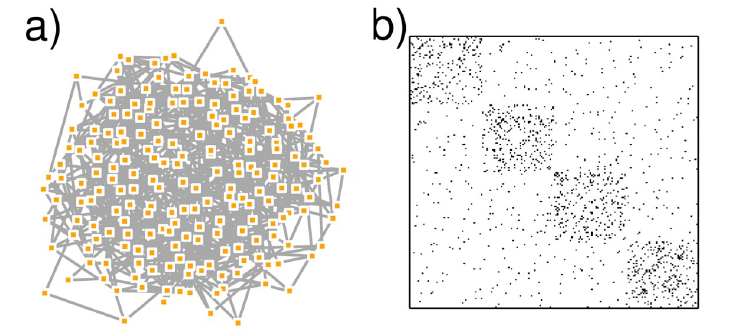
Fig 2. Synthetic network with 200 nodes and 700 edges generated with an SBM (see Tip 6) with 4 clusters of intraconnectivity and interconnectivity of 0.1 and 0.015, respectively. (a) Network visualization with Kamada and Kawai layout does not highlight any modular structure, whereas it exists. (b) Representation of the adjacency matrix with row and columns ordering consistent with the 4 clusters. Performed with the R package igraph. SBM, stochastic block